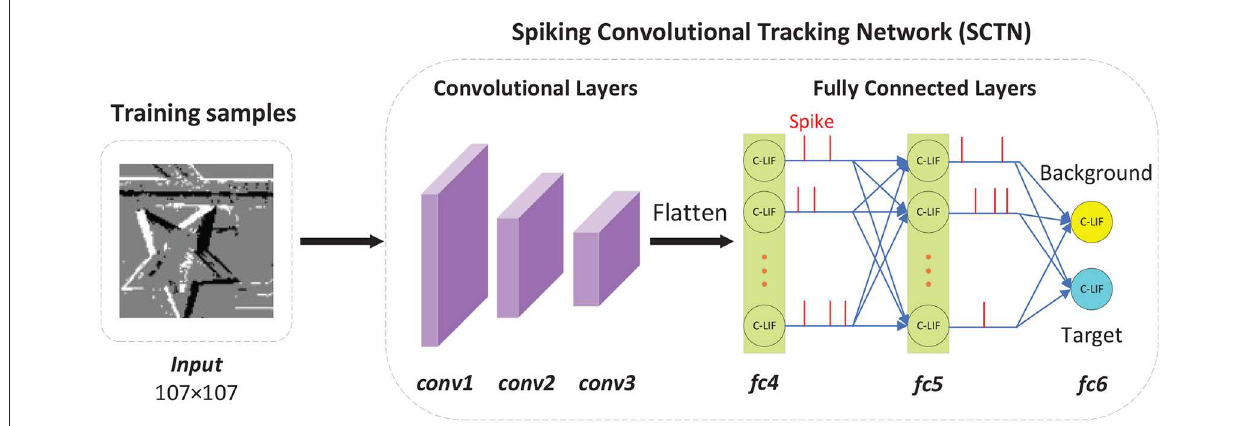
FIGURE2 The architecture of spiking convolutional tracking network. In this figure, the intensity images are reconstructed from all the events within 10ms. Note that the network architecture of SCTN is relatively simple, including three convolutional layers and three fully-connected layers. There are only two neurons in the last fully connected layer, representing background and target respectively.